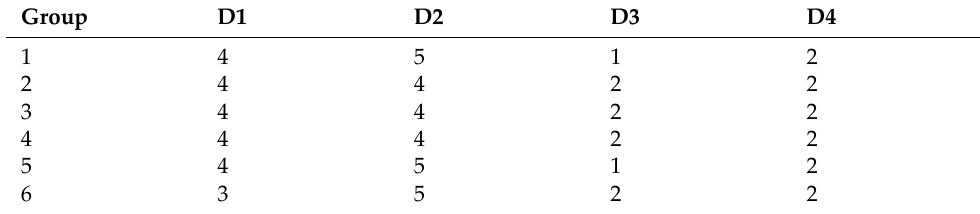
Table 17. Sample grouping.